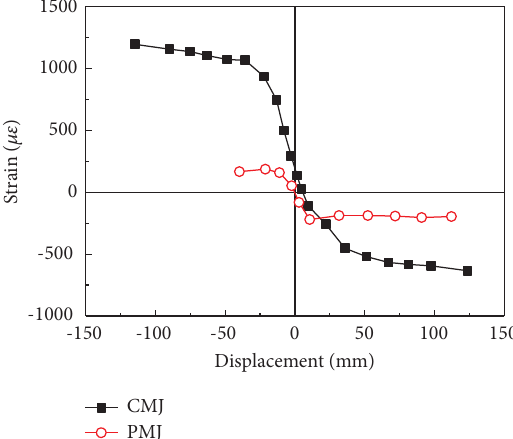
Figure 7: Relationship curves between steel strain and deformation of loading